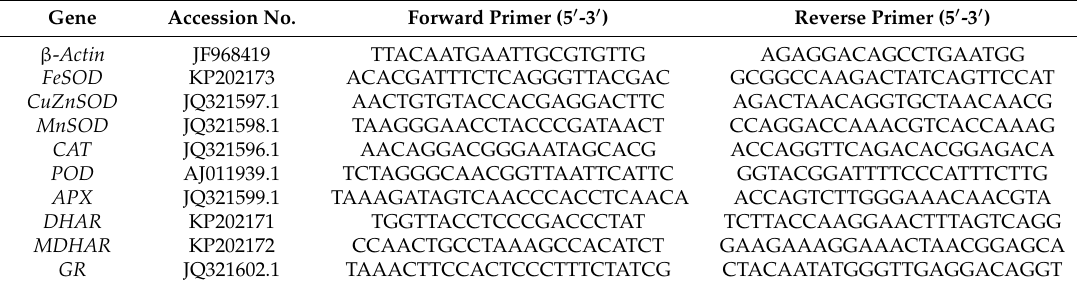
Table 3. Primer sequences and their corresponding GeneBank accession numbers used in real time quantitative